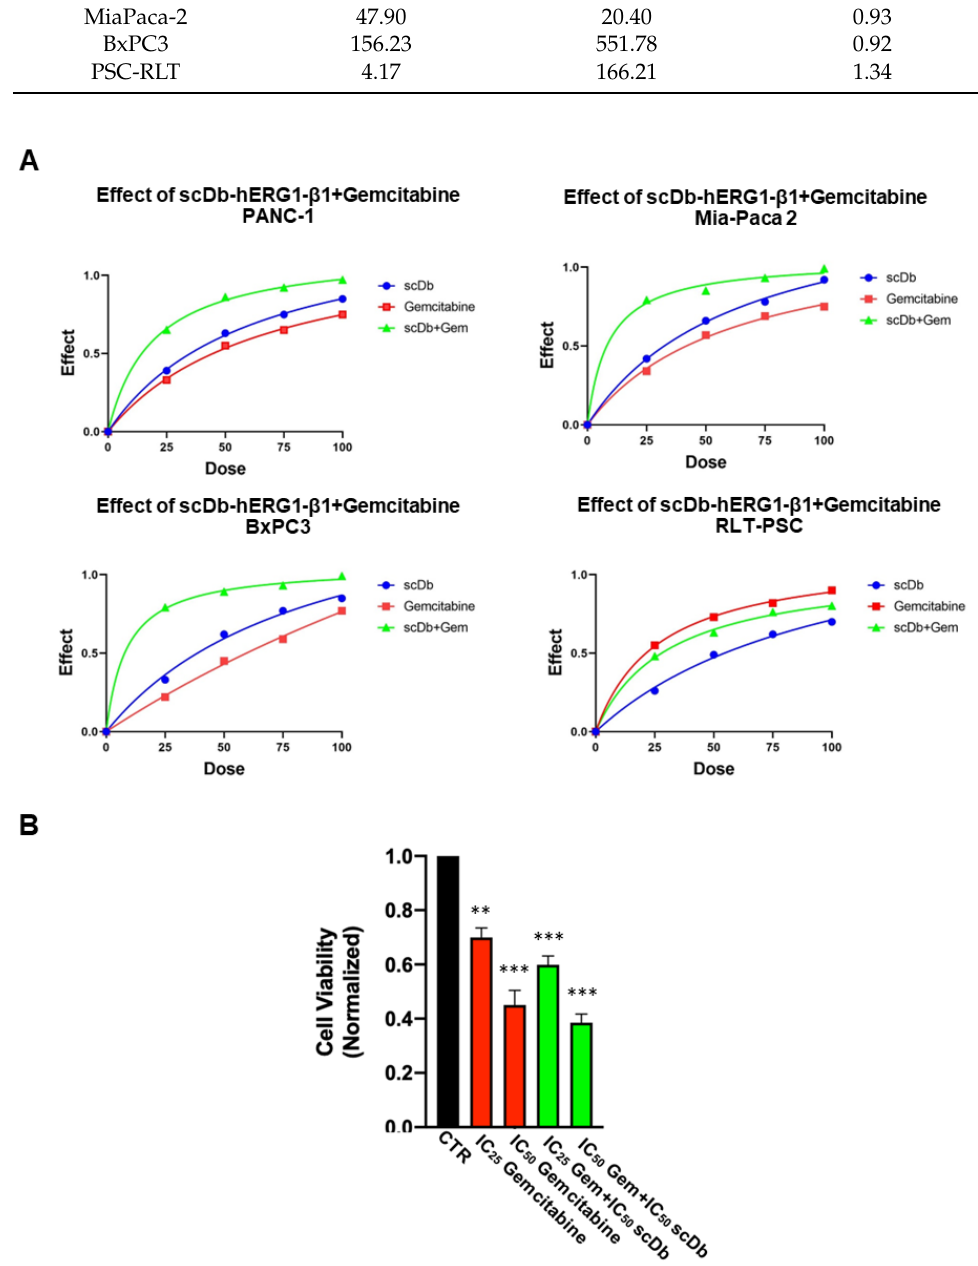
Figure 4. Effect of Gemcitabine and scDb-hERG1- β 1 and of their combination on the vitality of different cell lines (PDAC and PSC-RLT). ( A ) Effects of Gemcitabine (red symbols and lines), scDb-hERG1- β